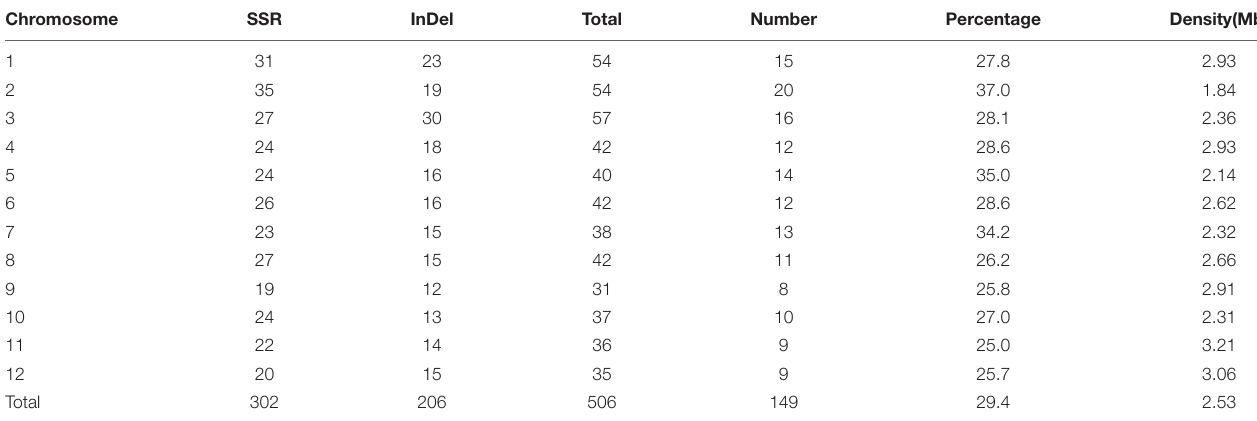
TABLE 1 | Summary of the markers used to develop the